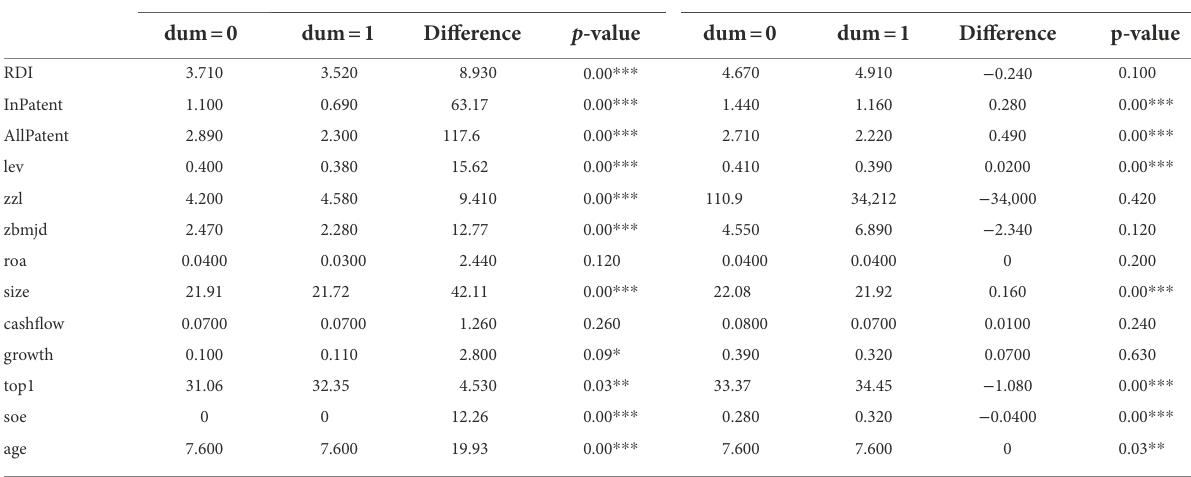
TABLE 4 Comparison of firms with and without major